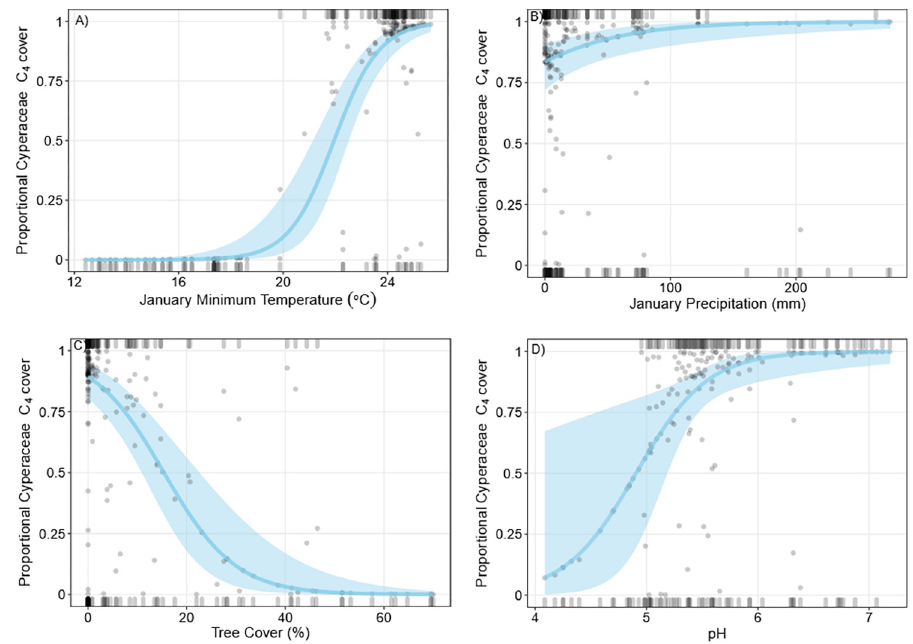
Fig 5. Binomial logistic regressions of proportional C 4 Cyperaceae cover. Grey points are partial residuals, blue lines and shaded bands are predicted outcomes of the regression and 95% confidence intervals respectively, and rugs were drawn to indicate observations with positive residuals (top of the plot) or negative residuals (bottom of the plot). For each plot (A-D), independent variables not depicted on the x-axis were held constant at their median value.